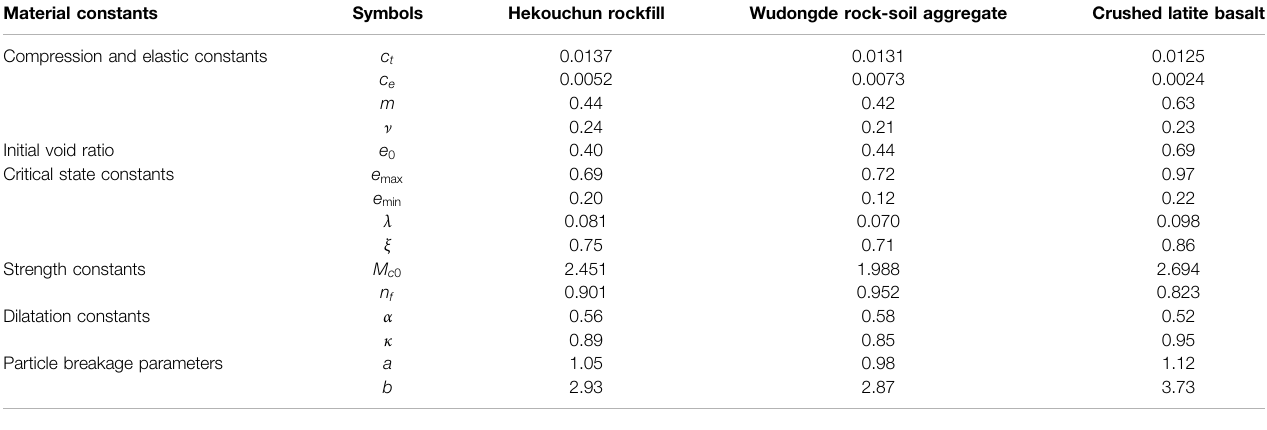
TABLE 1 | Material constants of the gravelly soils simulated in this study.